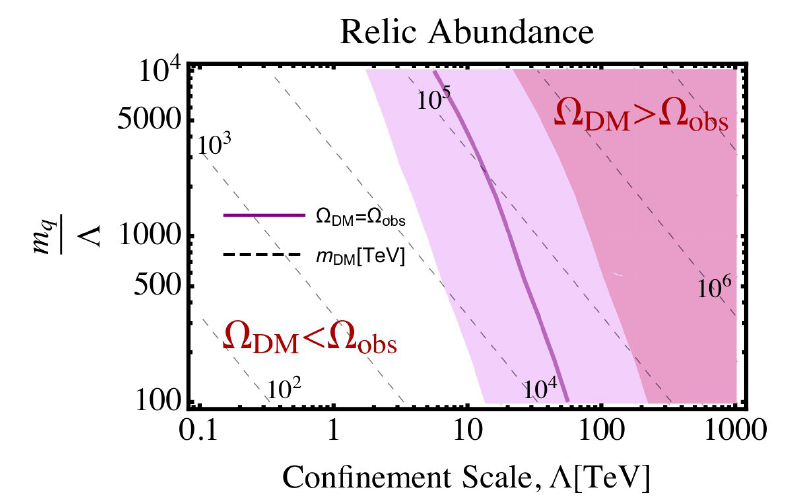
/ Λ (cid:48) versus confinement scale Λ (cid:48) for the relic baryon abun- Figure 24: Regions of m Q dance, accounting for bubble dynamics from the first order confinement transition, from Ref. [ 131 ] . Dashed lines show contours of constant m B